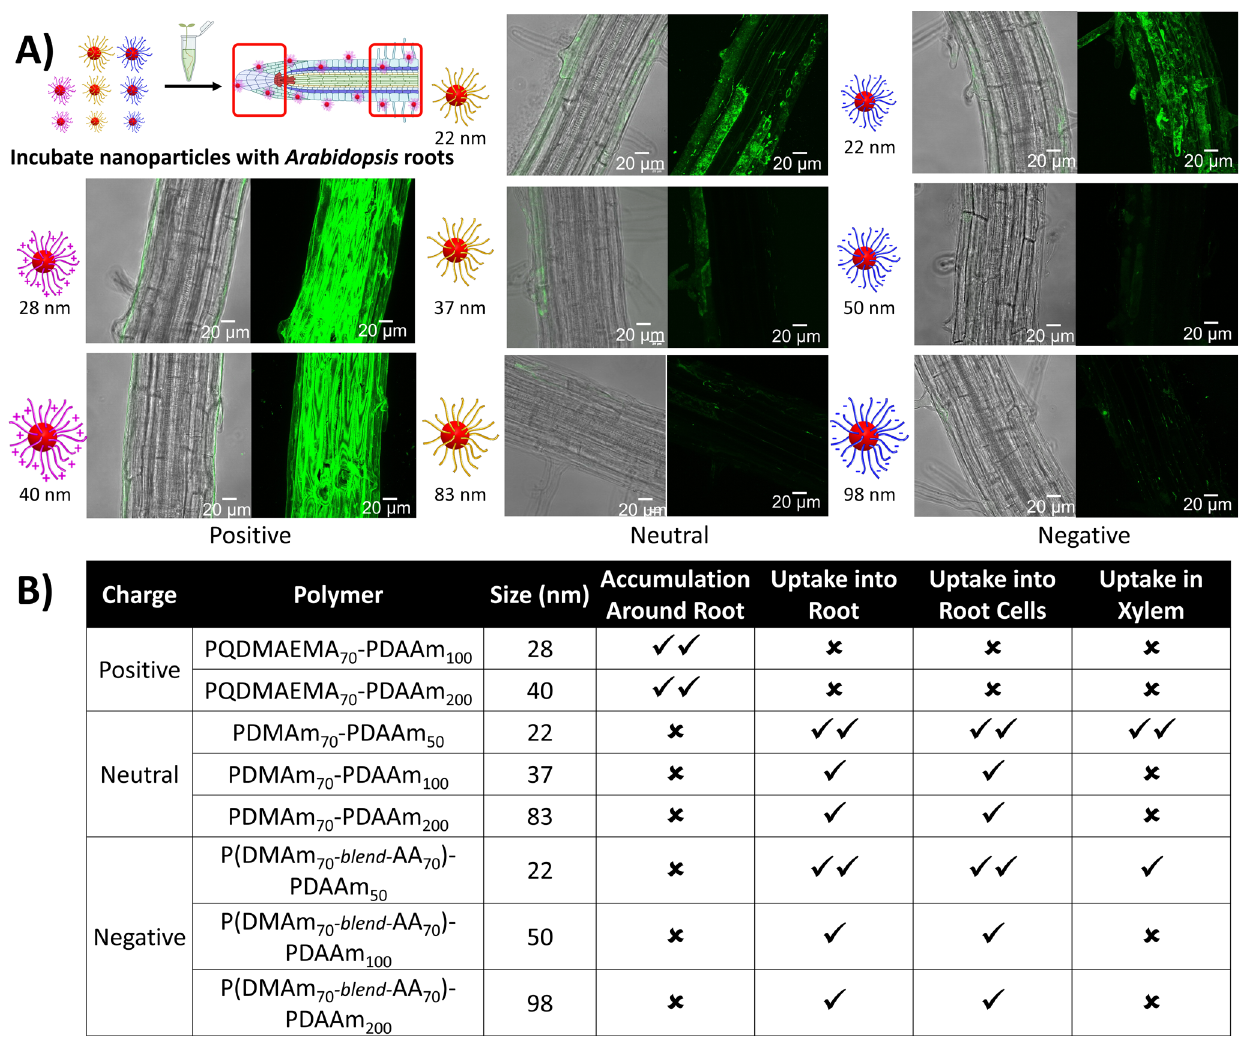
Fig. 2 | Certain nanoparticles penetrate intact roots. a Confocal microscopy images for the penetration and distribution of polymeric nanoparticles in Arabi- dopsis root hair zones after one hour of treatment in nanoparticle solution (1mg/ ml) at room temperature. b Summary table of the different levels of root pene- tration observed. Good ( ✓✓ ), poor ( ✓ ), or none ( ✗ ). Penetration and accumulation